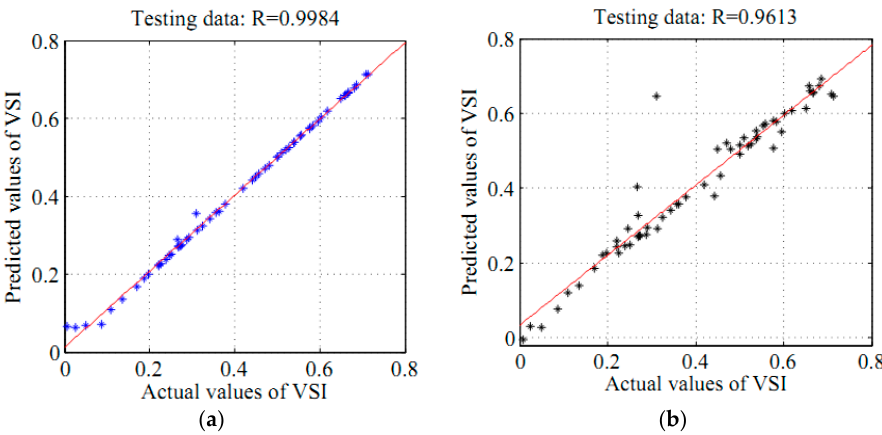
Figure 6. Linear fits between the actual and predicted VSI for IEEE 30-bus in testing phase using ( a ) ALO-SVR; ( b ) ANFIS.